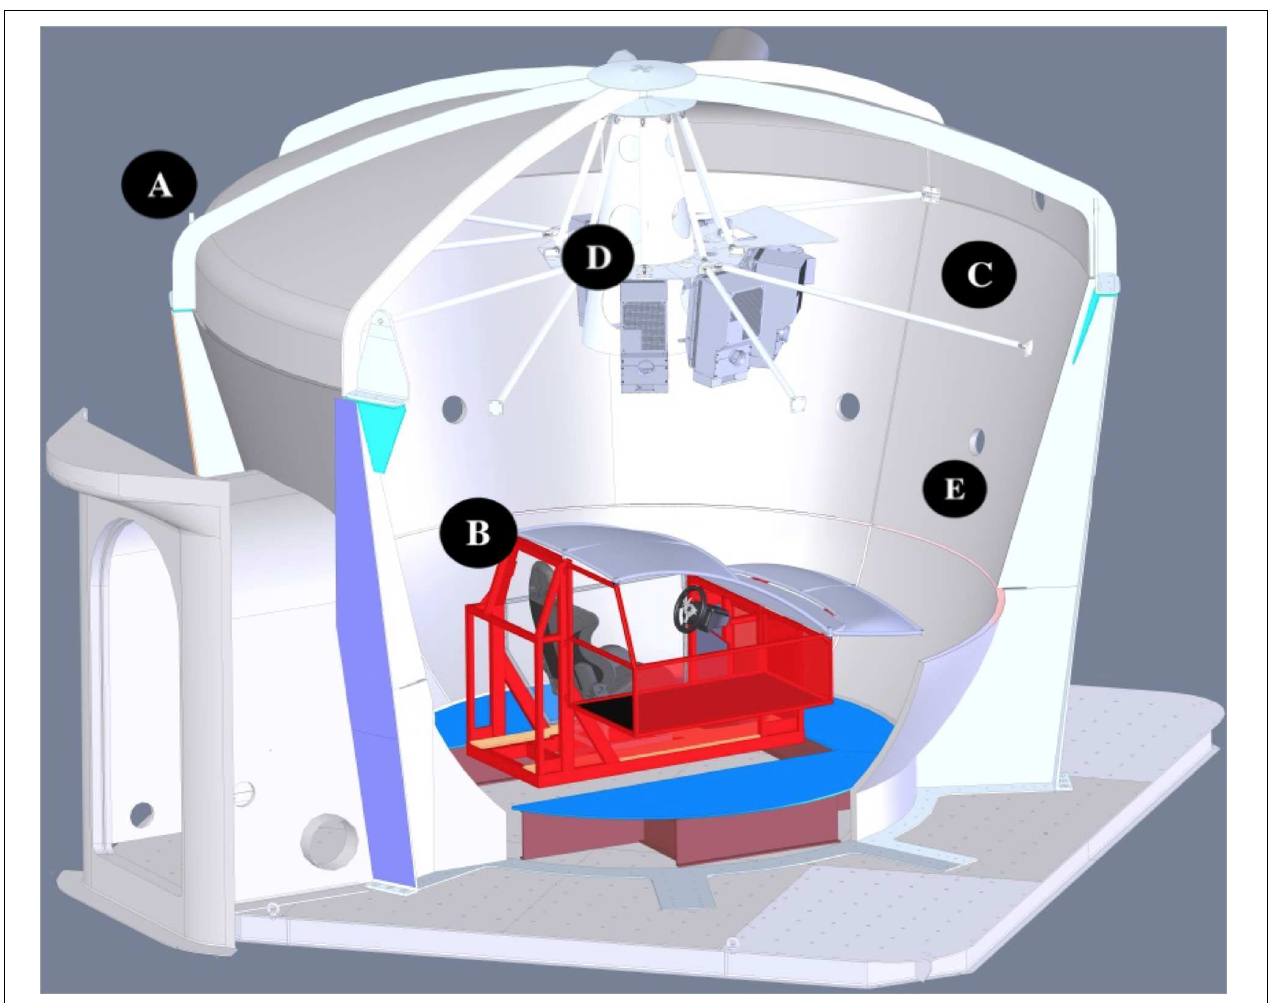
FIGURE 1 | Solidworks TM rendered cutaway view of StreetLab, a fiberglass dome that can be configured into different virtual reality environments (A). The driving task configuration consisted of a mock cab comprised of a steel frame, plastic body panels, a real car seat, a Logitech steering wheel and pedals, and a digital speedometer (B) . StreetLab contains a curved projection screen (C) , and six Eyevis ESP-LED projectors (D) that generate a 240 ◦ horizontal × 105 ◦ vertical field of view image. Vehicle and road contact sounds were conveyed over a 7.1 channel sound system. The center channel speaker is depicted (E) .